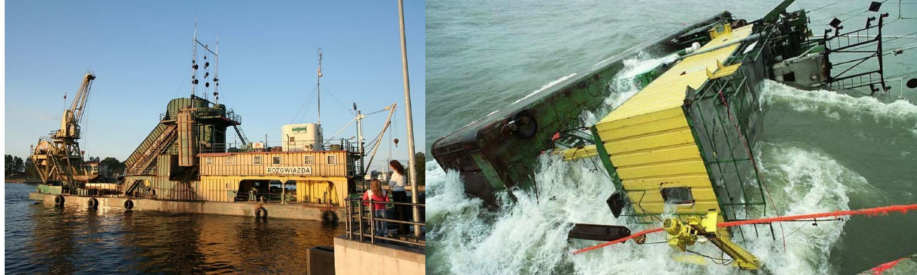
Figure 2. Dredger “Rozgwiazda” capsized. BRT 749, Length 51.4 m, Breadth 12.0 m, Draft 2.45